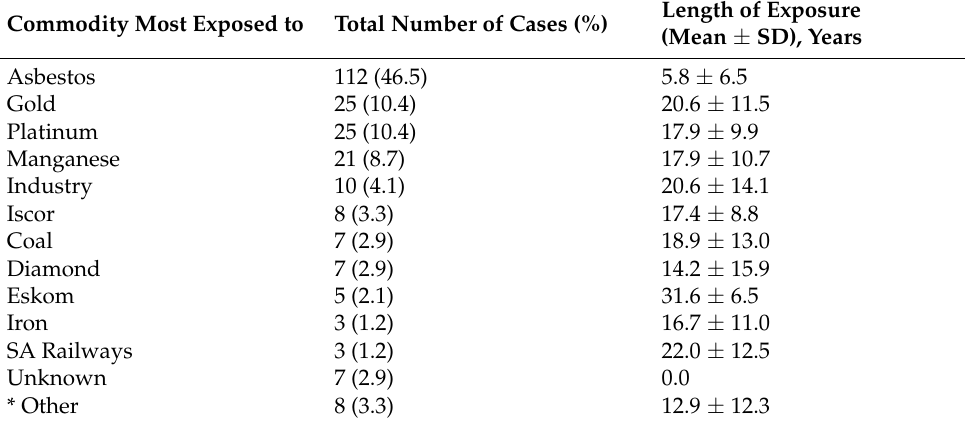
Table 2. Number of occupational cases by commodity most exposed to and mean exposure